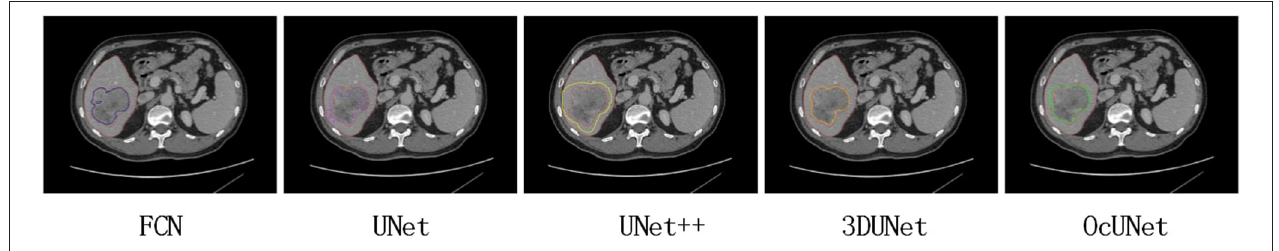
FIGURE 6 | Compared results of tumor segmentation with different methods.